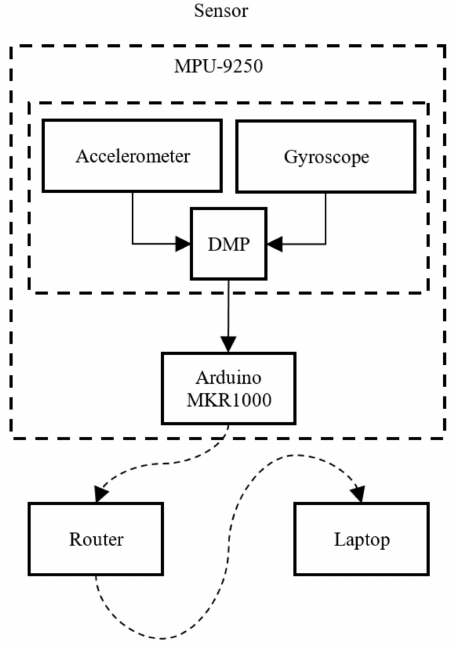
Figure 3. Block diagram of the data flow for one sensor through the system; solid arrows represent electrical connections and dashed arrows represent wireless